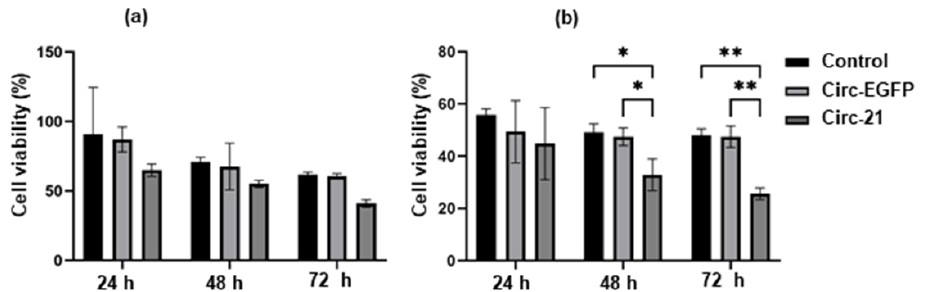
Figure 8. Effect of the combined therapy (DOXO + Circ-21) on MCF7 cell proliferation. DOXO concentrations of 0.02 µM ( a ) and 0.05 µM ( b ). The Circ-21 MCF7 cells treated with DOXO (Circ-21 + DOXO) showed a significant reduction in cell viability greater than with the separate treatments (only DOXO or only Circ-21). Values represent means ± SD ( n = 3). * p < 0.1 and ** p <